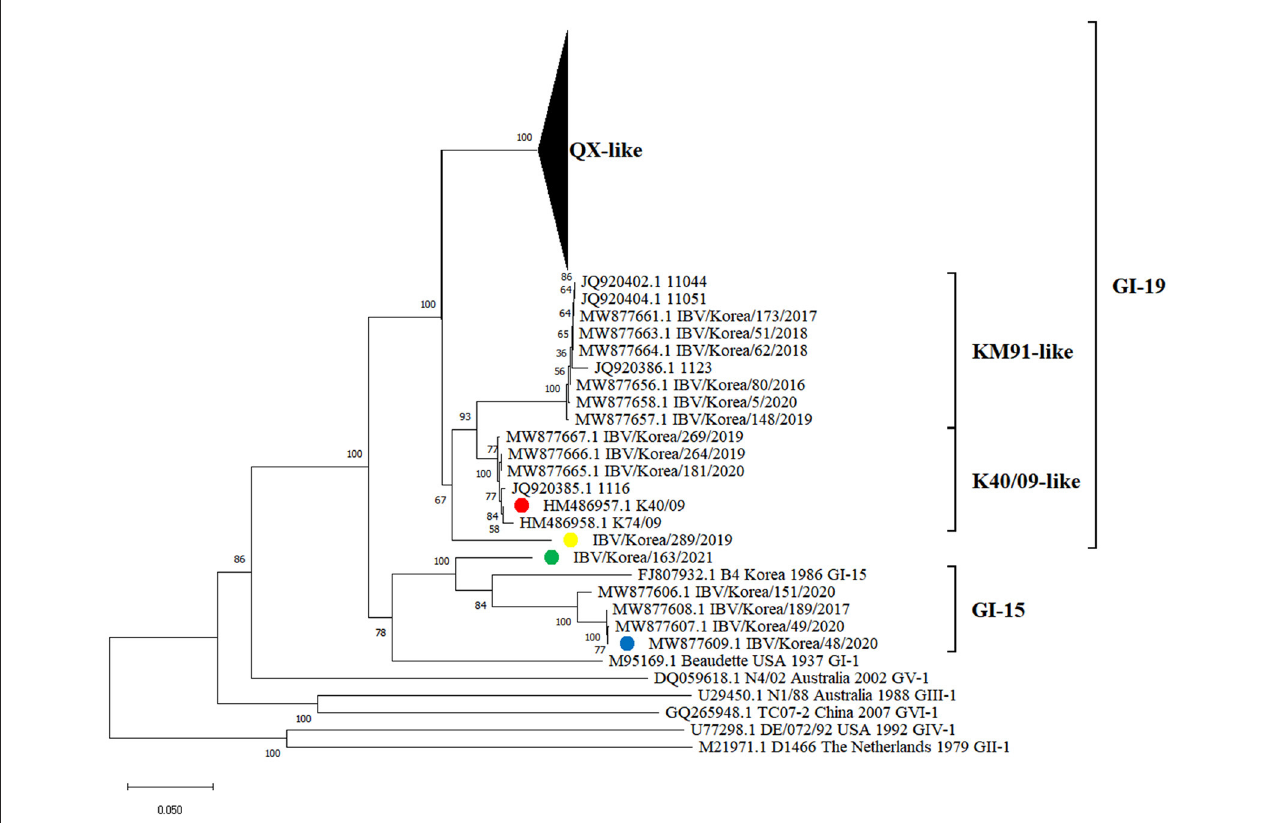
FIGURE1 Phylogenetic tree based on the S1 gene nucleotide sequences of IBVs. The IBVs newly isolated in this study are highlighted in yellow and green circles (plural). Strains highlighted in red and blue circles (plural) are putative parental strains of isolates, which are identified as progenitors of recombination events using RDP4 software in this study.